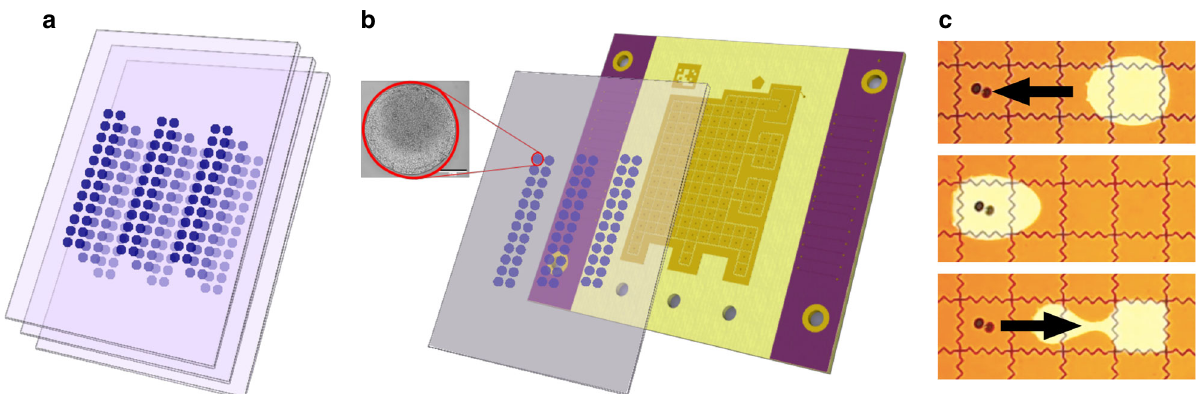
Fig. 2 Storing physically isolated spots of dehydrated DNA on glass cartridges enables high information density. a Spotted cartridges can be further organized into decks. b To retrieve data, the desired cartridge is fi rst loaded onto the DMF device consisting of an electrode grid used to perform retrieval functions. An actual magni fi ed spot is depicted, where the scale bar in the inset is 275 um. c Next, a water droplet sandwiched between the cartridge and electrodes is actuated to move under the spotted DNA for rehydration. Depicted is an actual droplet moving on the device. After recovery, we manually recover the sample and analyzed it to assess DNA recovery rate and contamination across samples sharing paths on the DMF device